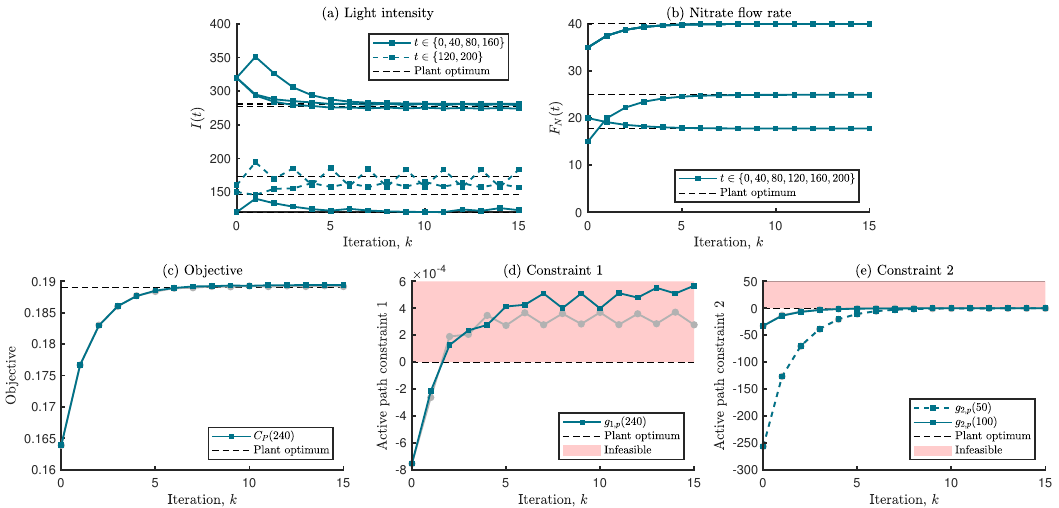
Figure 15. Multi-solution MA inputs and NLP functions using the mean solution approach shown as the blue square line. Top row, unstable inputs shown with a dashed line, stable with a solid line. Bottom row, objective and constraints which are active at plant optimum, where the standard MA approach is shown as the grey circle line.